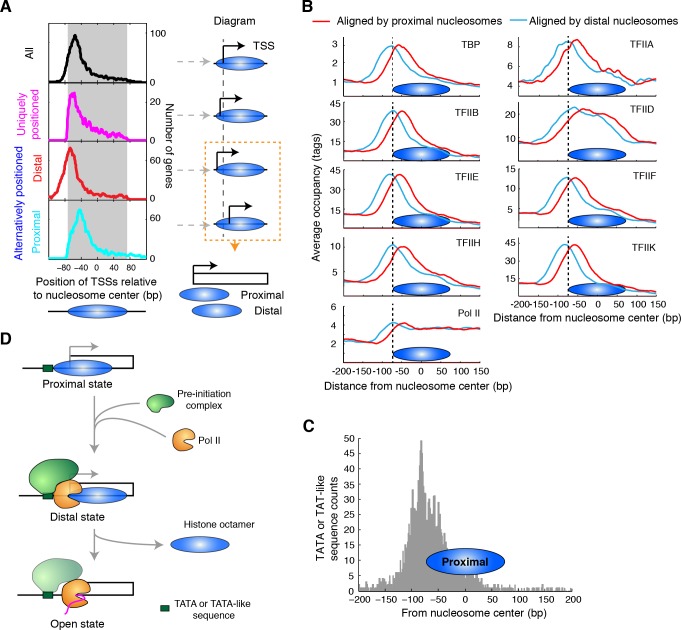
Alternatively positioned nucleosomes and transcription pre-initiation complex.(A) Plots (left) showing the locations of TSSs relative to the average centers of all overlapping TBB nucleosome positions shown in Figure 3C ('All', black) to uniquely positioned nucleosomes (magenta) and to the distally (red) and proximally (cyan) positioned nucleosomes. The gray area marks the region covered by the nucleosome core. The cartoon diagrams on the right illustrate the location of the TSS relative to the nucleosome dyad. (B) Area showing the average occupancy of subunits of the pre-initiation complex (TBP, TFIIA, TFIIB, TFIID, TFIIE, TFIIF, TFIIH, TFIIK and RNA polymerase II (Pol II); determined by ChIP-exo) (Rhee and Pugh, 2012) aligned at the center of the proximal (cyan) and the distal nucleosomes (red), determined by the TBB approach. (C) Bar graph showing the distribution of TATA box and TATA-like sequences of all genes (Rhee and Pugh, 2012) aligned at the dyad of the proximal nucleosomes. (D) Illustration of the 3-step model for transcription initiation mediated by alternatively positioned nucleosomes.DOI:
http://dx.doi.org/10.7554/eLife.16970.02310.7554/eLife.16970.024Figure 6—source data 1.Source data for Figure 6, with genes and coordinates of TSSs, unique, proximal and distal nucleosome positions.